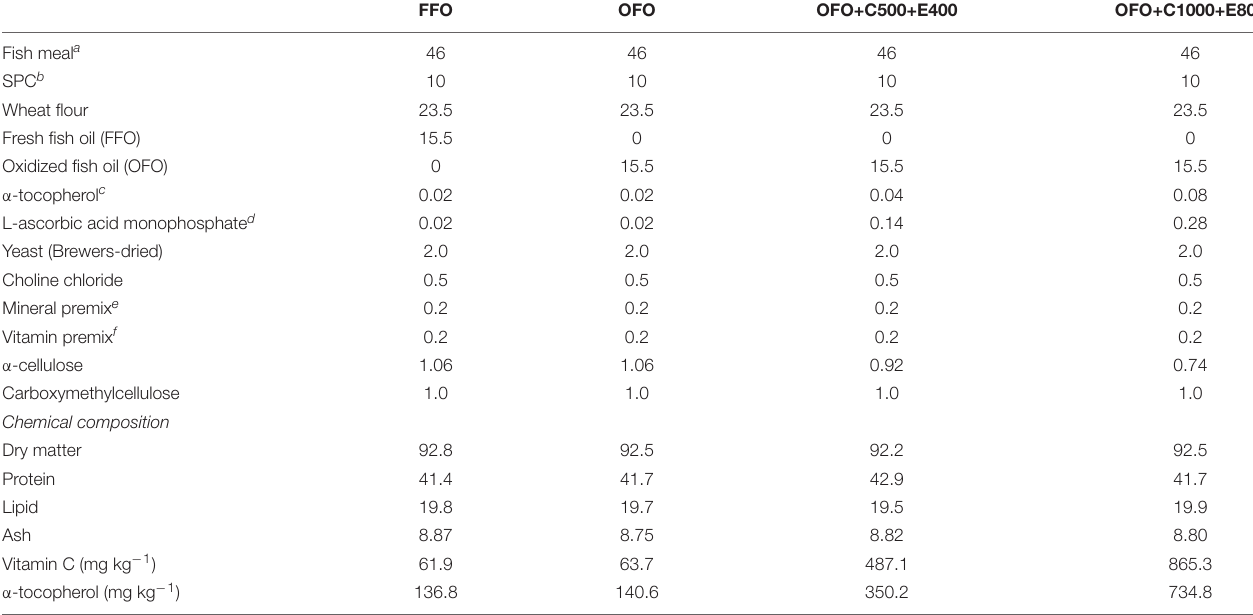
TABLE 1 | Formulation and proximate composition of the experimental diets (% dry matter). FFO OFO